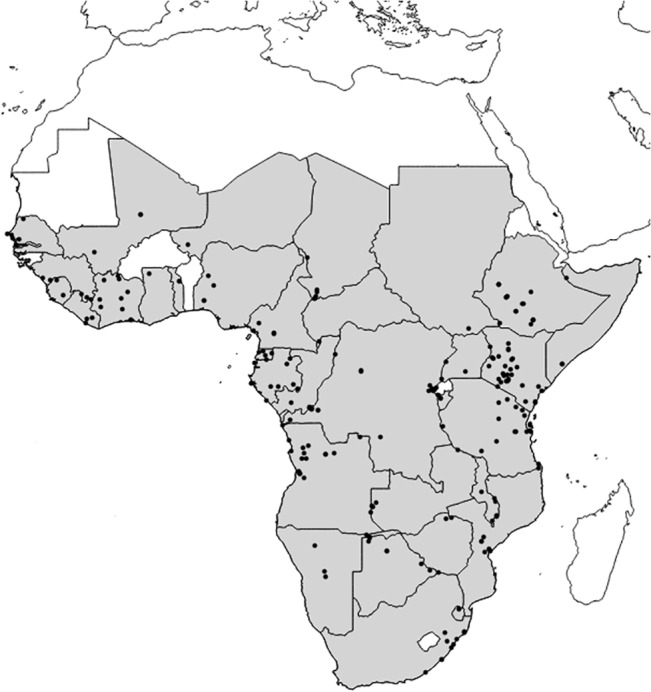
Sampling area.Shaded countries are those with at least one locality sampled, which are showed as black dots.